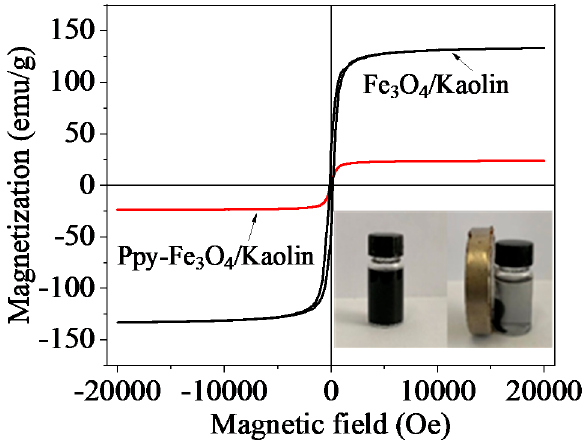
Figure 4. Magnetic hysteresis loops of Fe 3 O 4 / Kaolin and PPy-Fe 3 O 4 / Kaolin (The inserted picture is the effect of magnetic separation with an outer magnet).